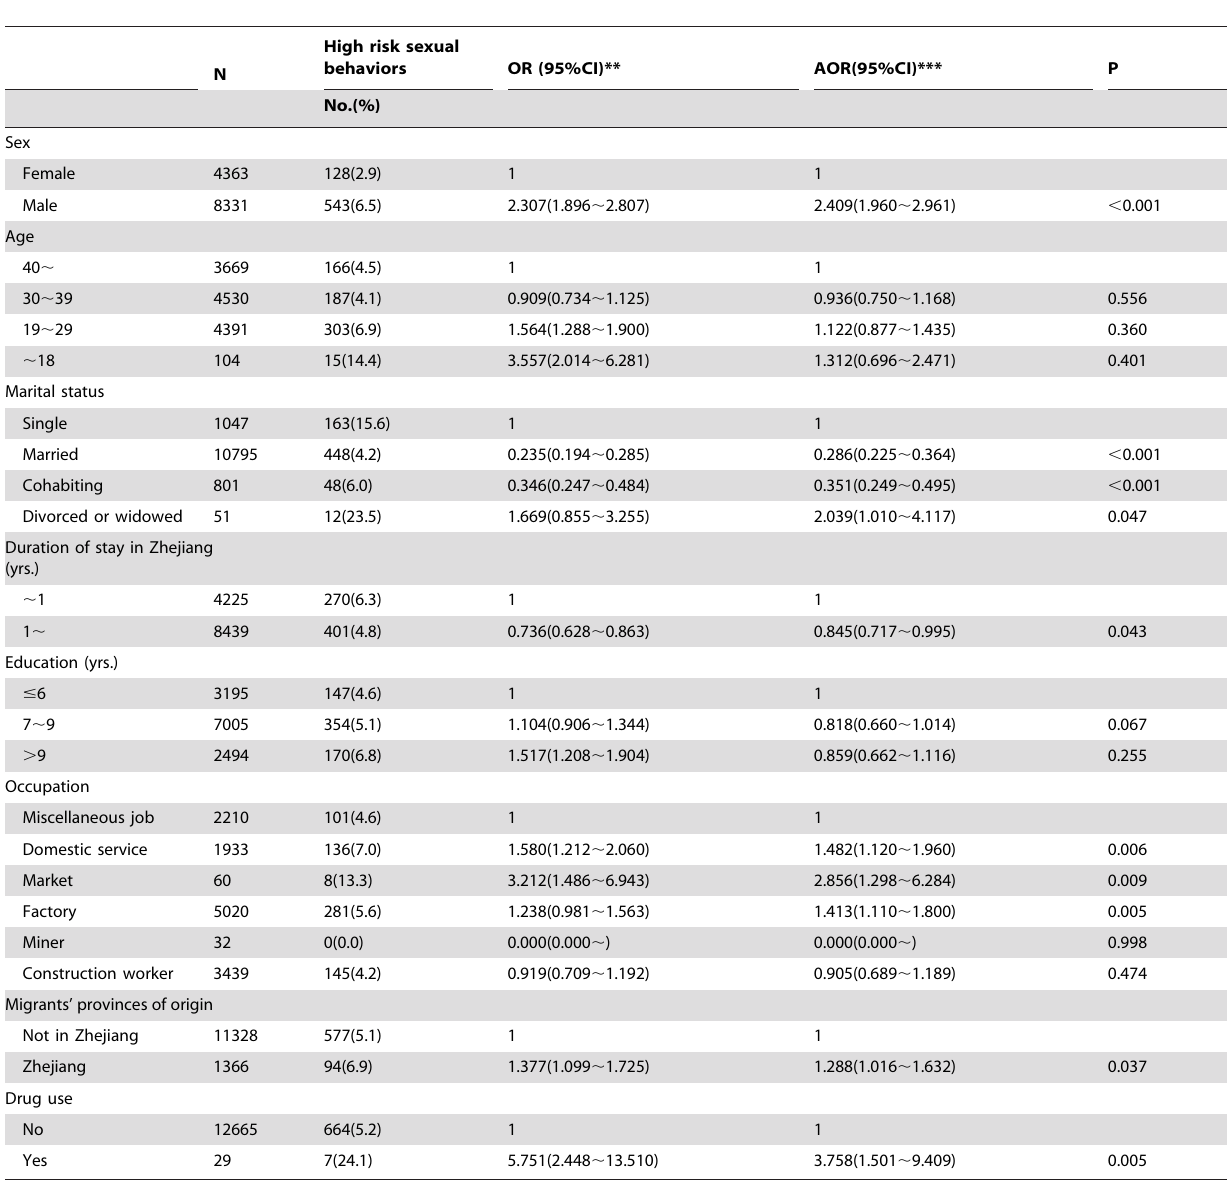
Table 3. Risk factors for high risk sexual